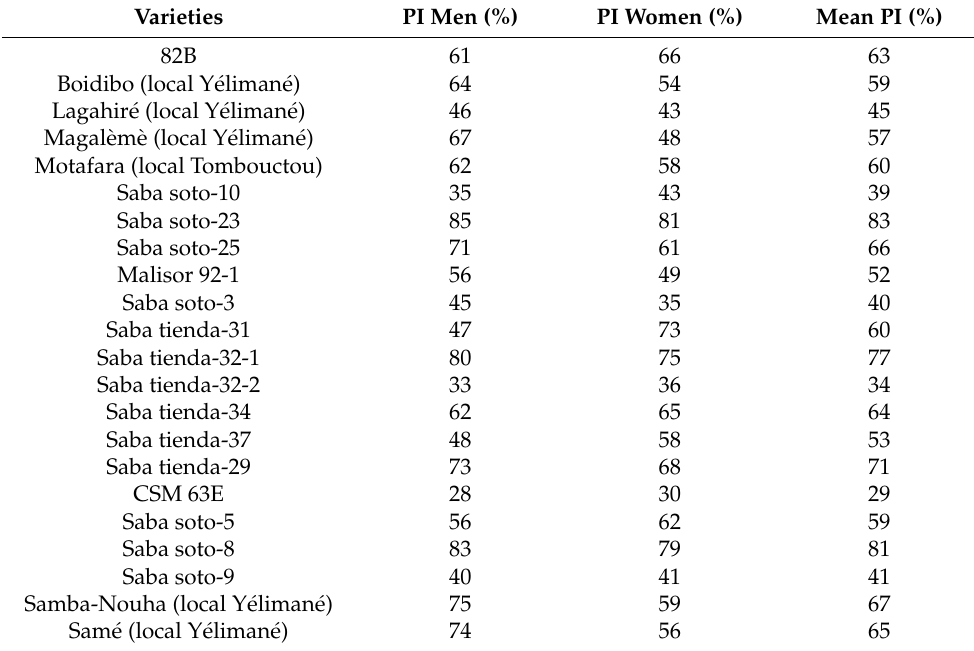
Table 10. Preference index of 22 sorghum varieties tested in Yaguin é , Gory, and Foungou in the 2014/2015 cropping season.